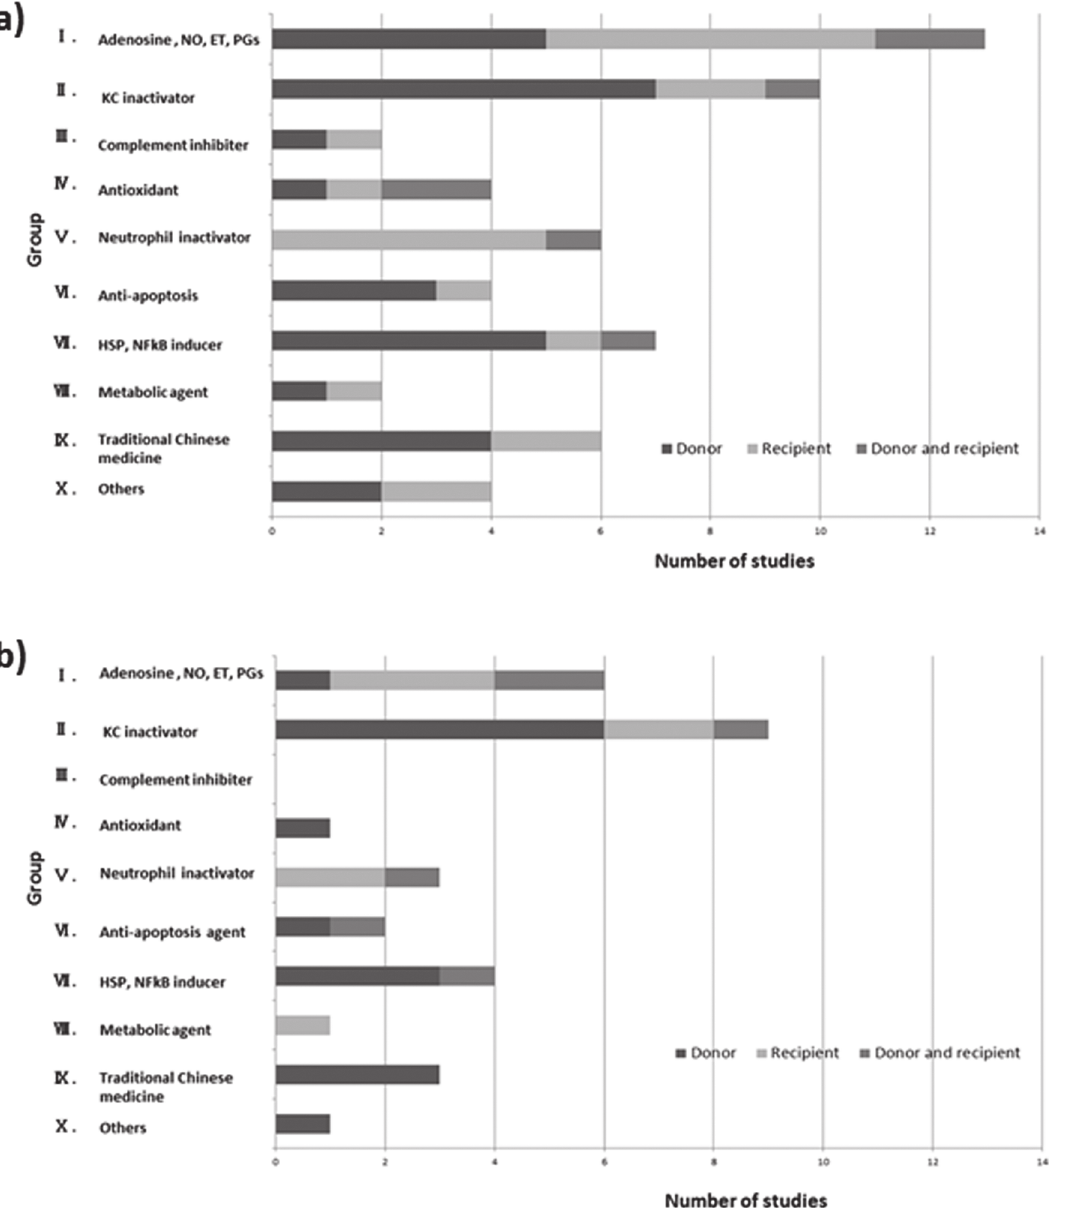
Fig 2. Categorization and number of studies in total (a) and in the subgroup analysis that examined survival benefits